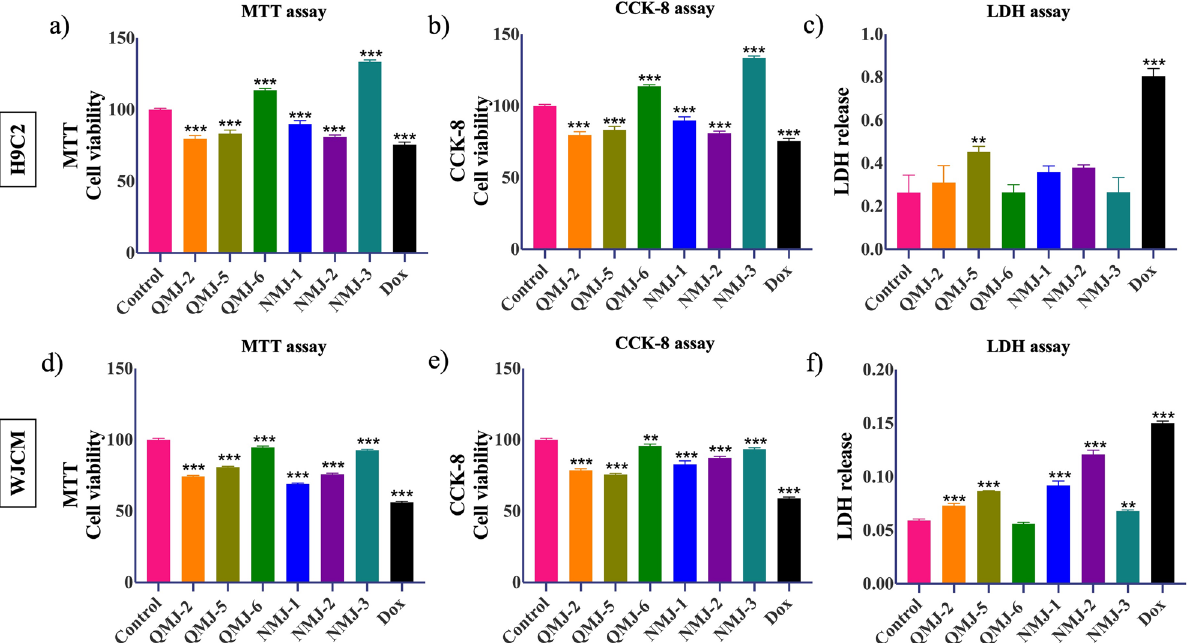
Figure 2. Effect of quercetin and cinnamic acid analogues on cell proliferation and cytotoxicity. H9C2 cells and WJCM after treatment with QMJ-2,-5,-6 or NMJ-1,-2,-3 were assessed for cell viability by using ( a , d ) MTT cell viability assay and, ( b , e ) cell counting kit-8 assay. ( c , f ) Cytotoxic effects of these compounds were estimated in terms of LDH release. Data represented as mean ± SEM (n = 3), *p < 0.033, **p < 0.002, ***p < 0.001. Dox